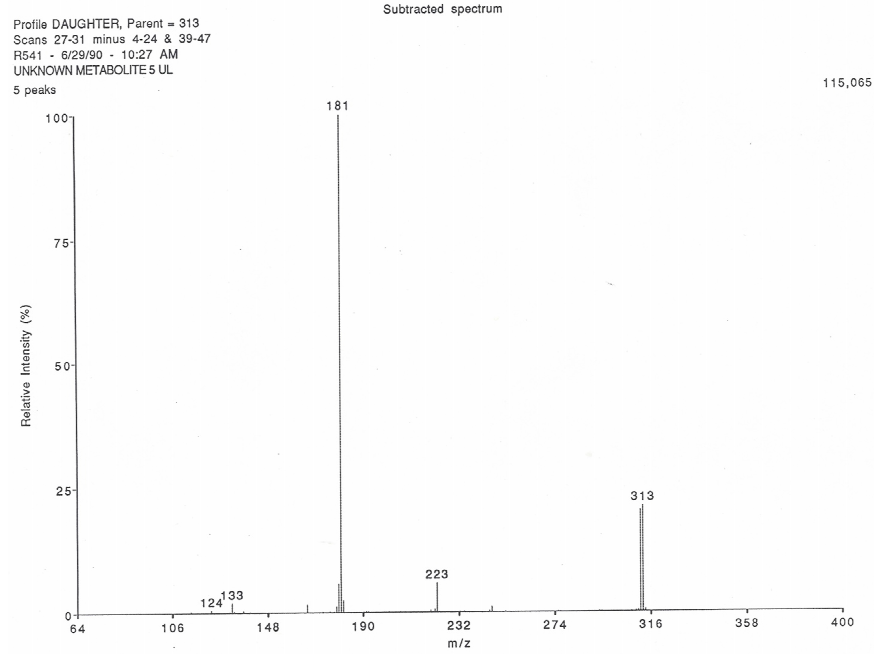
Figure 3. HPLC/MS/MS chemical ionization spectrum of theonosine.